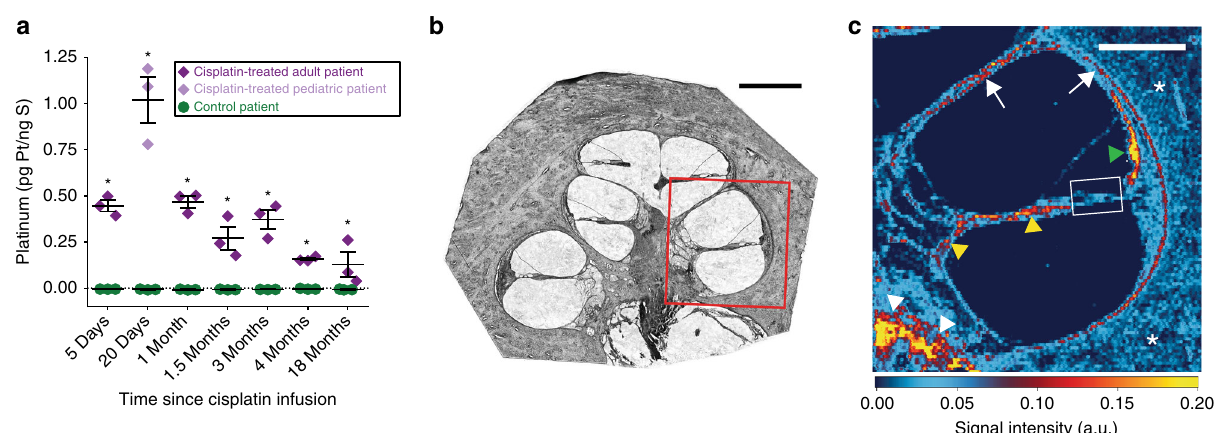
Fig. 4 Cisplatin is retained in human cochleae long after cessation of treatment. a Platinum concentrations measured in cochlear sections of human temporal bones. Matched pairs of patients who received cisplatin chemotherapy and control (cisplatin-naive) patients are plotted by the time elapsed between the patient ’ s last cisplatin infusion and their death. Each data point represents an individual 20 µ m cochlear section. Multiple two-tailed t- tests with correction for multiple comparisons by the Holm – Š idák method were used to determine signi fi cance. Data are expressed as mean ± s.e.m. * P < 0.05. b Representative bright fi eld image of a cochlear section prior to ICP-MS analysis. Similar sections were digested whole and analyzed for total cisplatin content. This section was laser ablated in the region outlined in red. Scale bar = 1 mm. c Laser ablation ICP-MS image of platinum distribution in the area in the red box in b from a patient who was treated with cisplatin. This patient died 25 days after their last cisplatin infusion. Green arrowhead marks stria vascularis, yellow arrowheads mark cochlear nerve fi bers, white arrowheads mark the boundary between the cochlear nerve and the bone of the cochlear modiolus, white arrows mark the endosteum which lines the cochlear canal, asterisks mark surrounding cochlear bone, and white box frames organ of Corti. Scale bar = 500 µ m. Platinum signal intensity values are in arbitrary